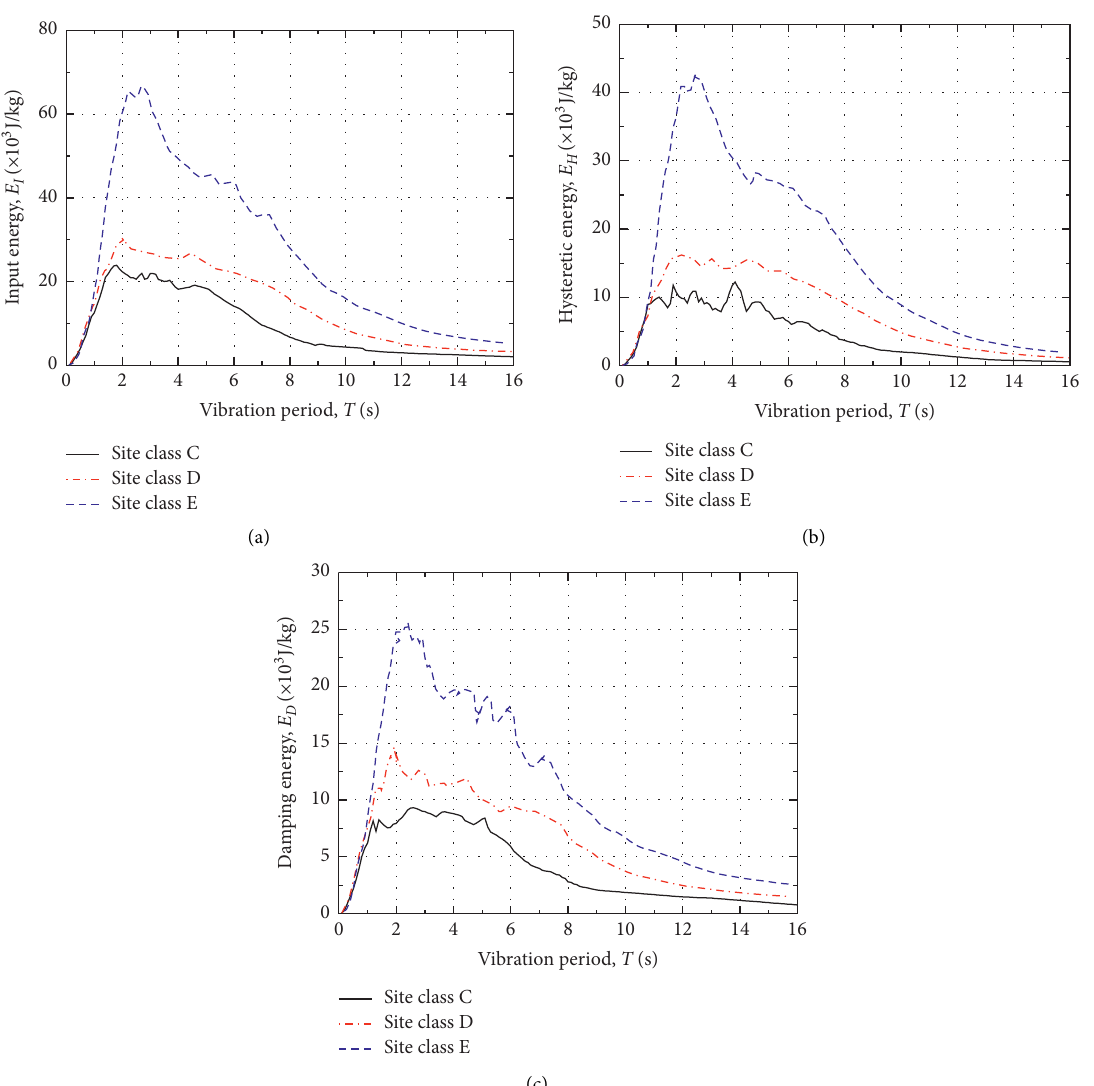
Figure 8: Energy response spectra affected by site class under far-field harmonic ground motions. (a) Input energy. (b) Hysteretic energy. (c) Damping energy.